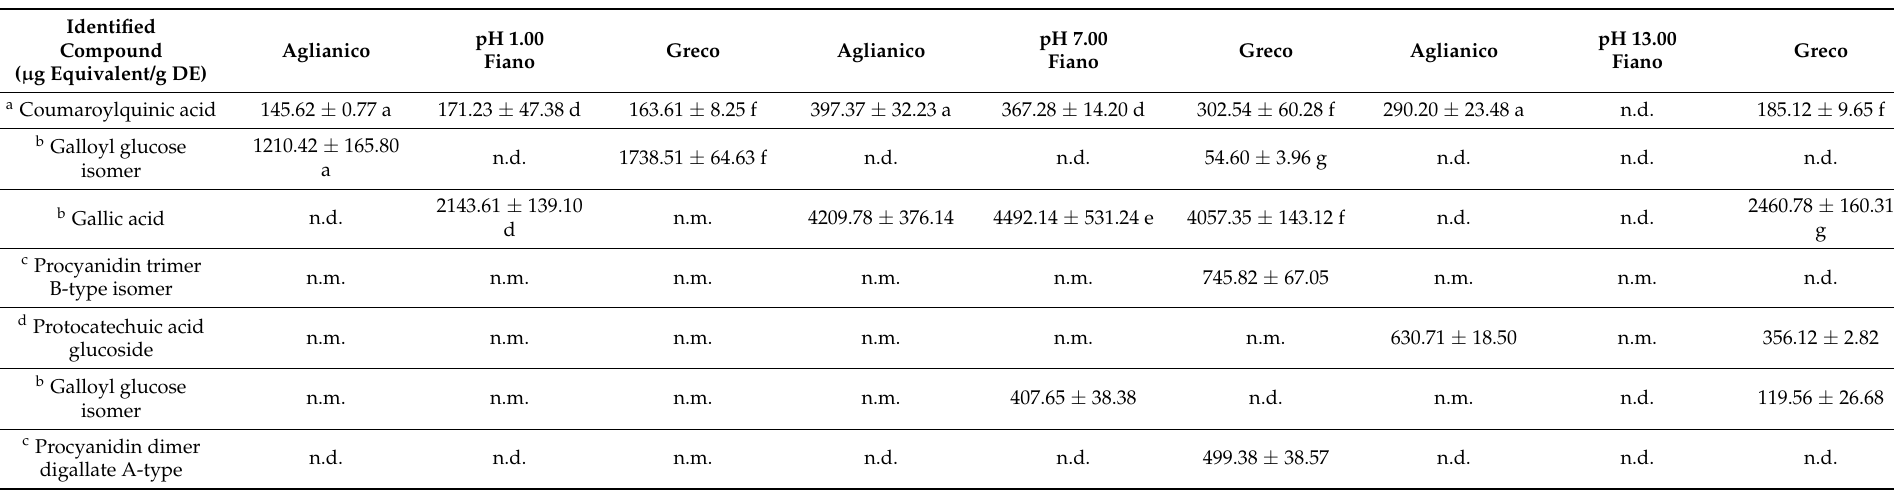
Table 2. Quantification of main phenolic compounds identified in “Aglianico”, “Fiano”, and “Greco” grape canes extracted at pH 1.00, 7.00, and